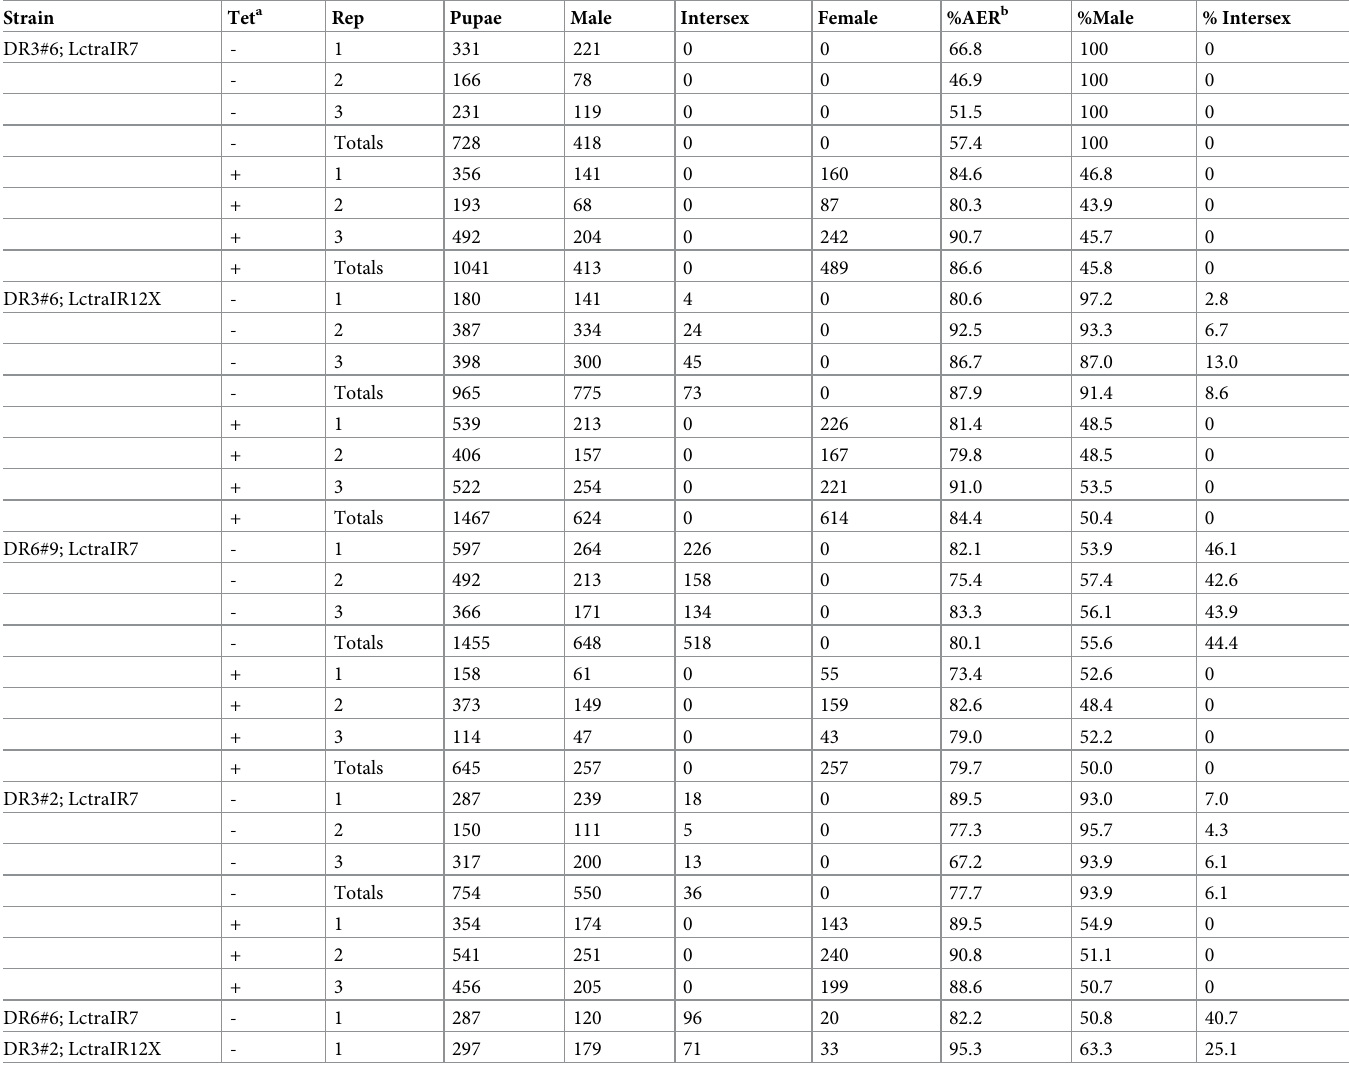
Table 1. Rearing efficiency and female transformation of double homozygous